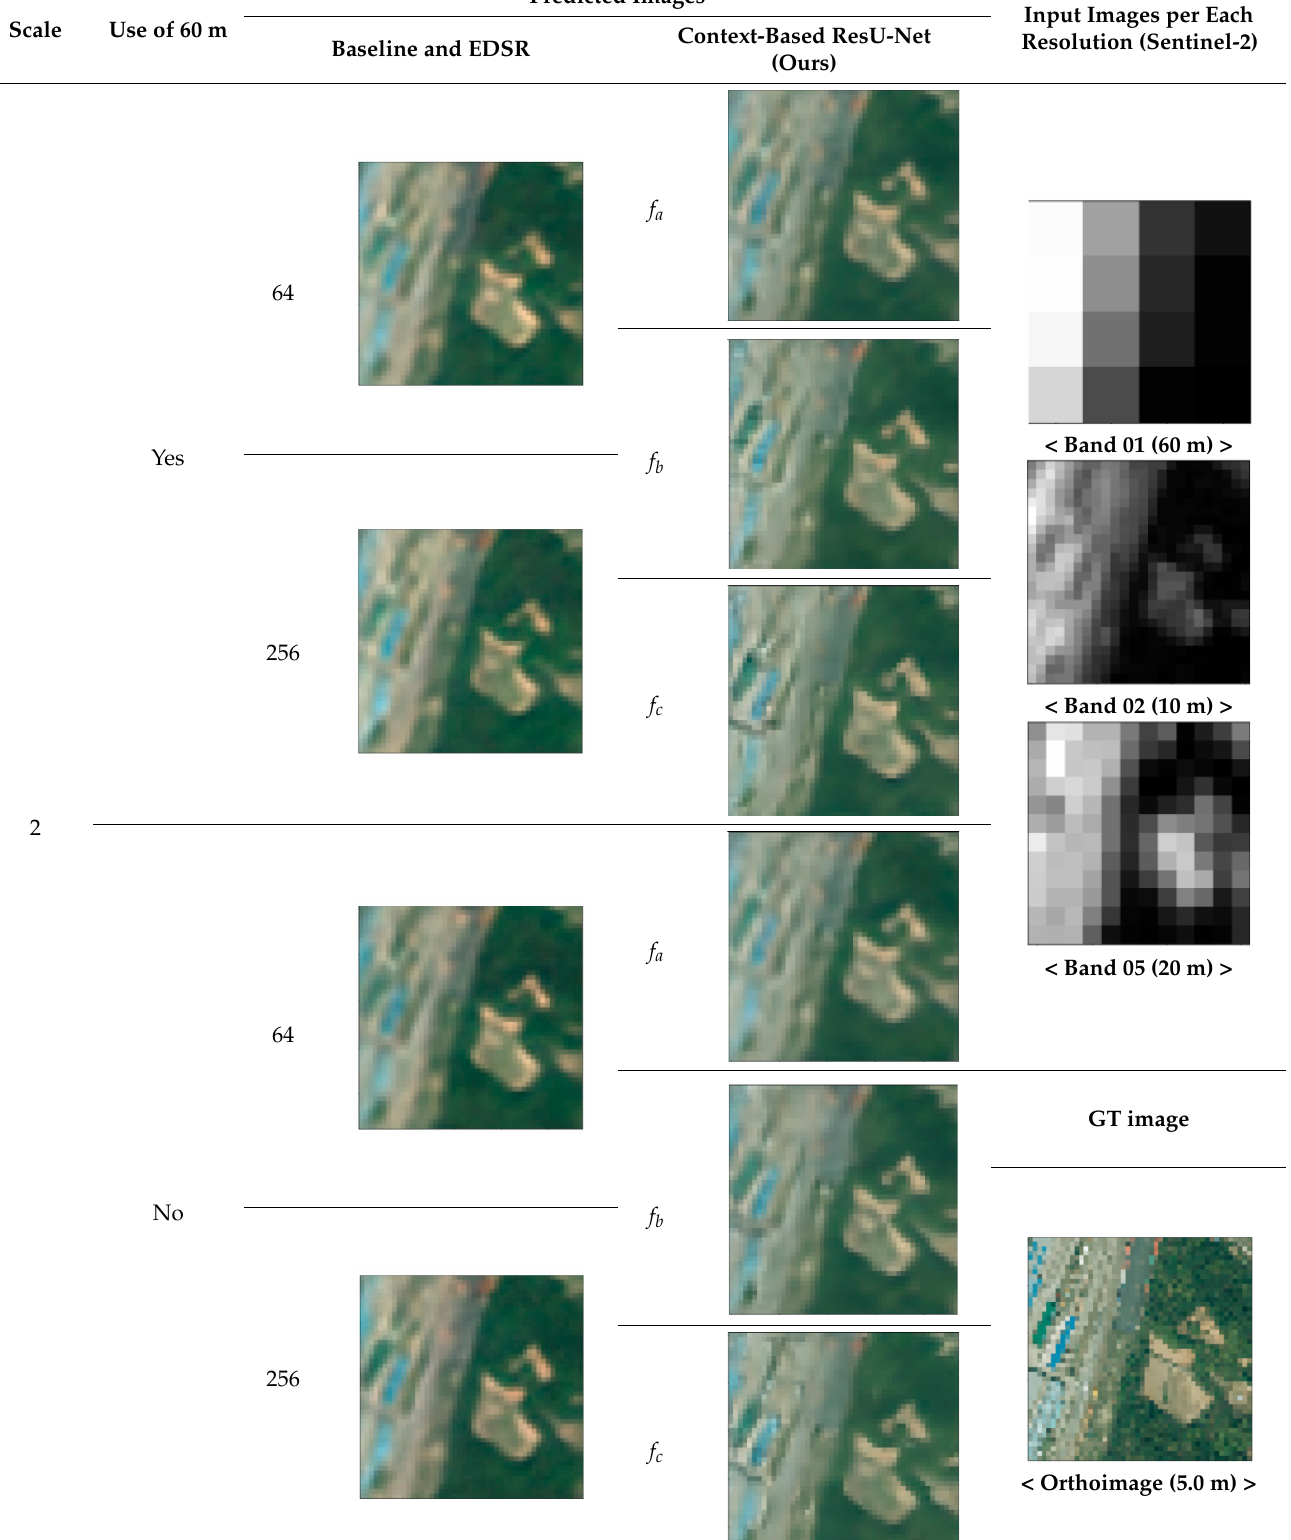
Table 8. Predicted images of Sentinel-2 and corresponding GT image (urban/forest